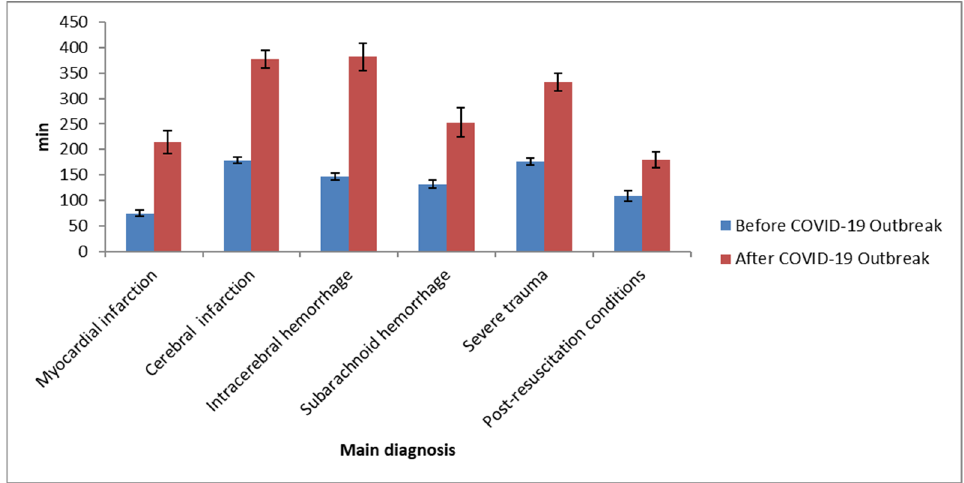
Figure 2. The difference in the emergency department length of stay (EDLOS) by main diagnosis before and after COVID-19 outbreak.